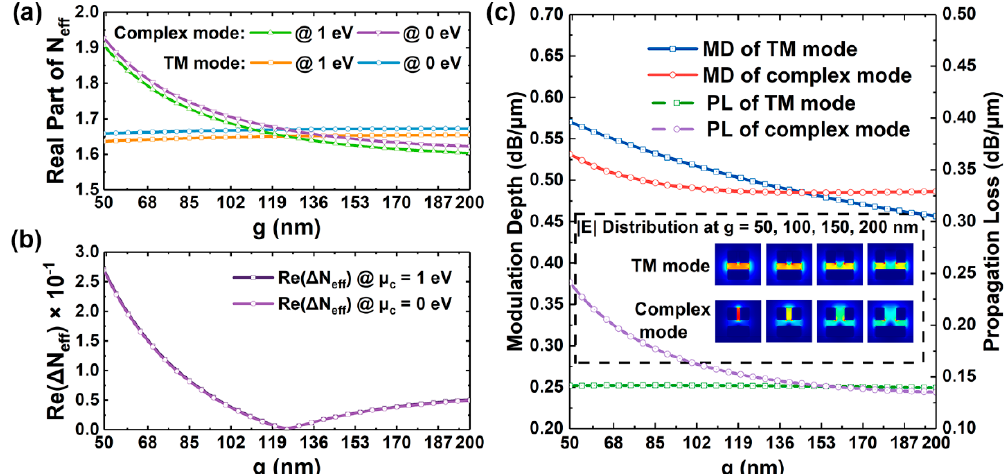
Figure 10. (a, b, c) are Re( N eff ), Re( Δ N eff ), modulation depth as well as propagation loss of the TM mode and complex mode in the DBOSW modulator versus g , respectively; the illustration in (c) shows the variation of electric field distribution for both modes versus g .